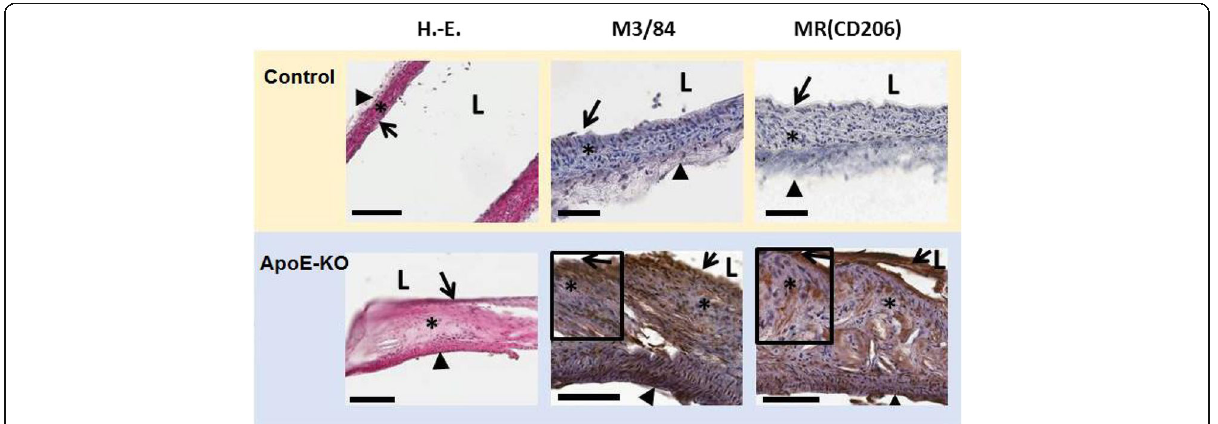
Fig. 5 Representative images of HE, M3/84 (macrophages) and MR (CD206) immunohistochemistry. In control mice, no plaques with macrophages were observed, while fibrous/fibroatheromatous plaques were present in the aortas extracted from ApoE-KO mice. The lesions (fatty streaks and fibrous plaques) showed high amounts of MR + macrophages (100 μ m ( bars ), vascular lumen ( L ), intima ( arrow ), media ( asterisk ), adventitia ( arrowhead